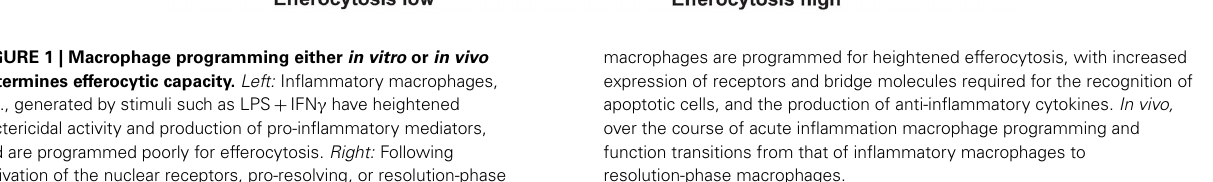
macrophages are programmed for heightened efferocytosis, with increased expression of receptors and bridge molecules required for the recognition of apoptotic cells, and the production of anti-inflammatory cytokines. In vivo, over the course of acute inflammation macrophage programming and function transitions from that of inflammatory macrophages to resolution-phase